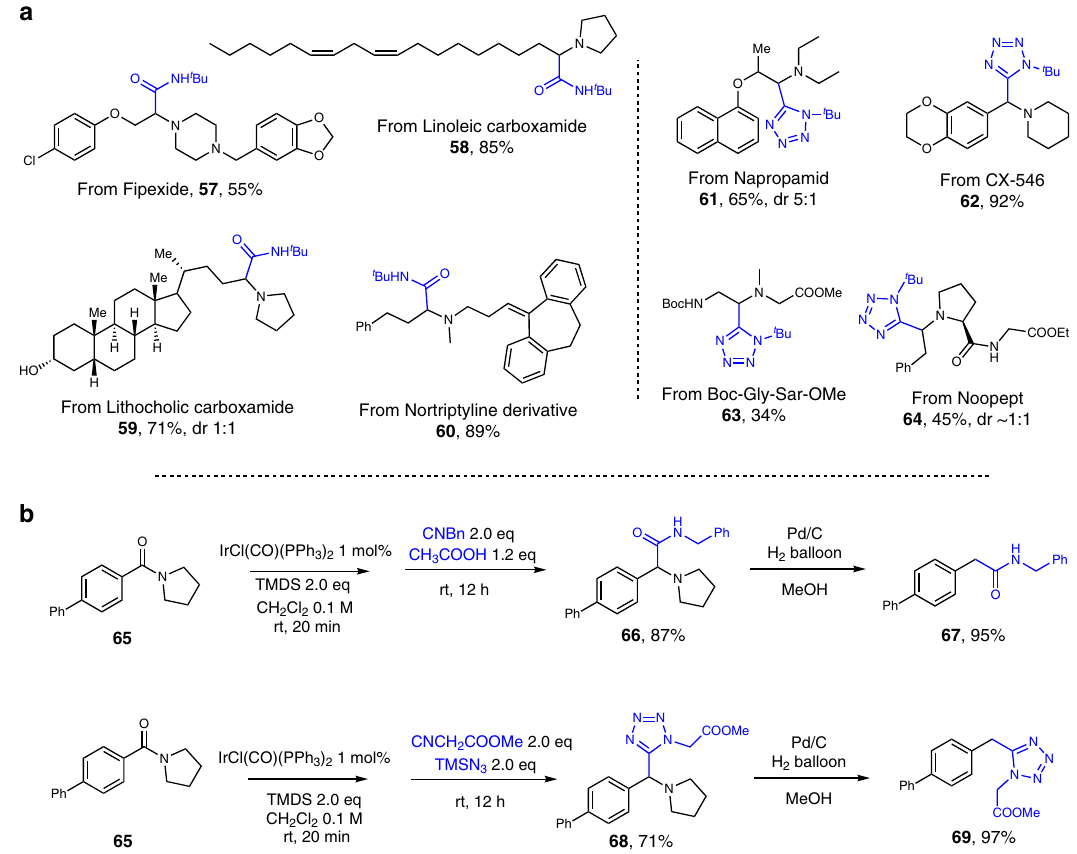
Fig. 5 Synthetic application. a Late-stage functionalization of bioactive molecules and derivatives using amide reductive Ugi-type reactions. b Synthesis of bioactive molecules via reductive Ugi-type reactions followed by hydrogenation. Standard condition: amide 0.3 mmol, IrCl(CO)(PPh 3 ) 2 1 mol%,